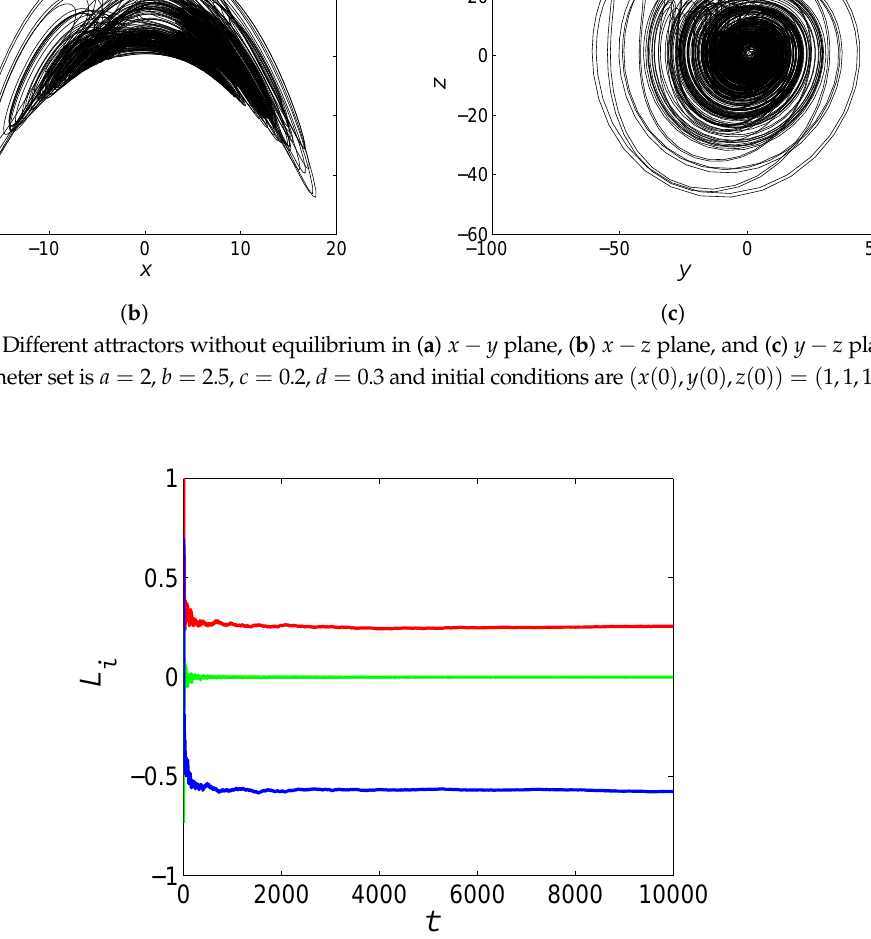
Figure 2. Calculated Lyapunov exponents ( L 1 (red), L 2 (green), and L 3 (blue)) of the system when a = 2, b = 2.5, c = 0.2, d = 0.3 and ( x ( 0 ) , y ( 0 ) , z ( 0 )) = ( 1,1,1 ) . It is noted that chaos of the system is indicated by L 1 >